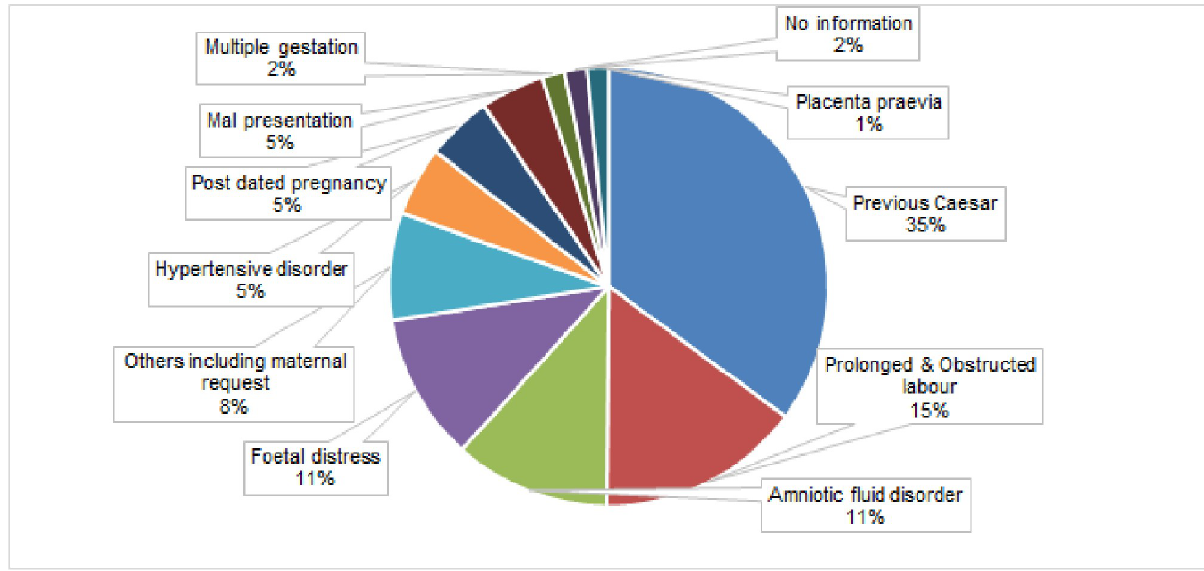
Fig 2. Clinical indications of CS in for-profit private hospitals in urban Bangladesh.